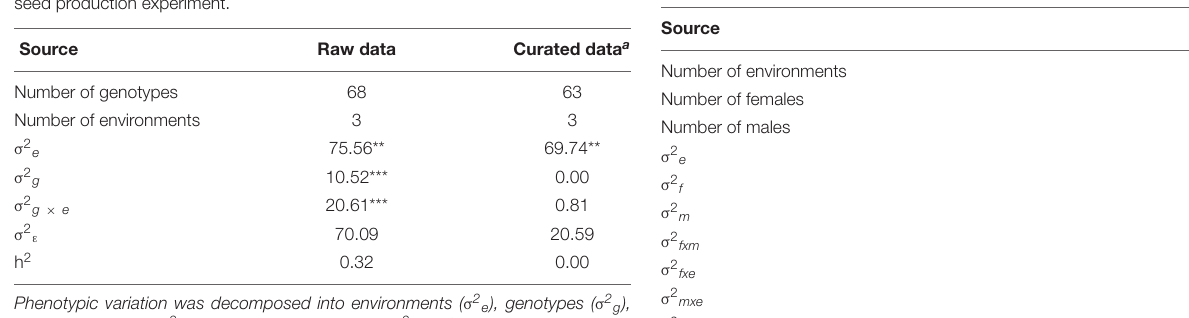
TABLE 3 | Variance components and narrow-sense heritability (h 2 ) for seed yield (g m − 2 ) in the hybrid seed production